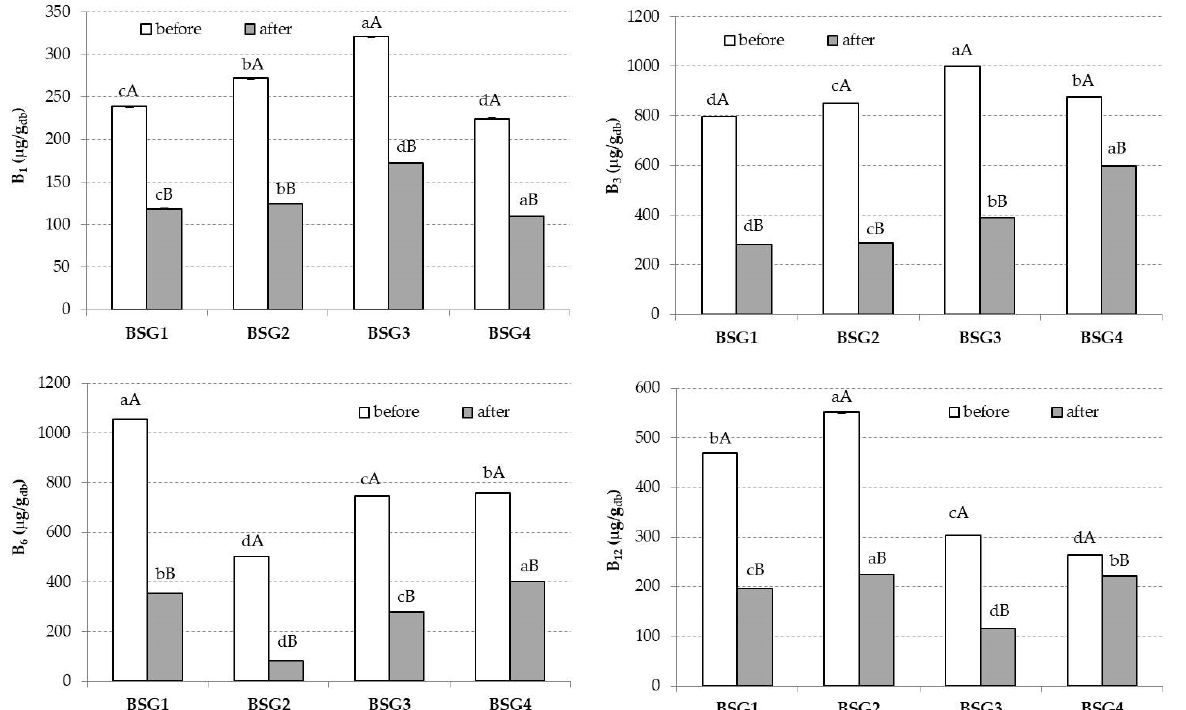
Figure 4. Mean values and standard deviations (error bars) of B group vitamin (B1, B3, B6, B12) contents in four different brewers’ spent grain (BSG) samples. For each mineral, small letters indicate homogeneous groups established by the ANOVA ( p < 0.05) by comparing BSGs before and after in vitro digestion. For each mineral, capital letters indicate homogeneous groups established by the ANOVA ( p < 0.05) by comparing samples before and after in vitro digestion for each BSG sample. Note: db, dry weight.